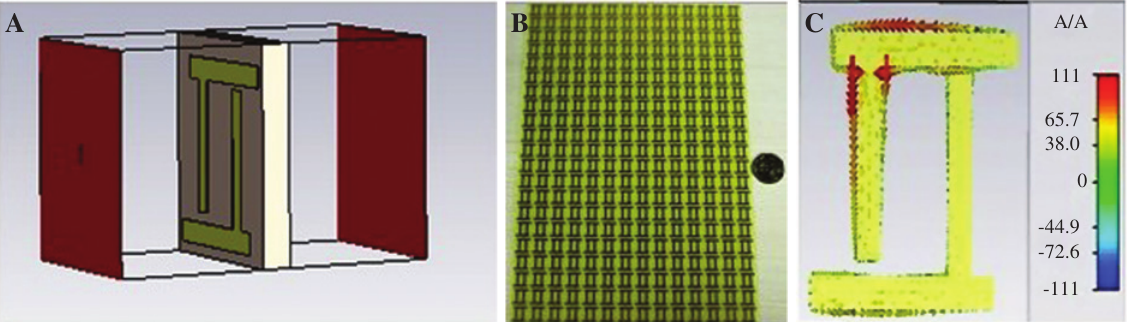
Figure 2: (A) Simulation geometry for z -axis wave propagation, (B) fabricated prototype for measurement, and (C) current distribution of the unit cell at the frequency of 9.56